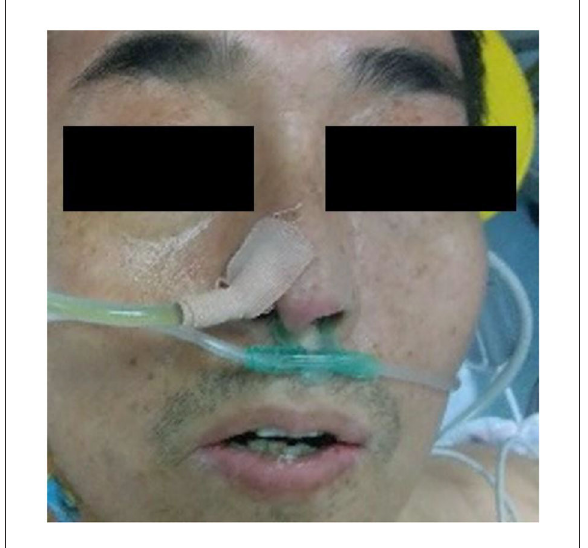
FIGURE8 Original image of a patient with anemia.